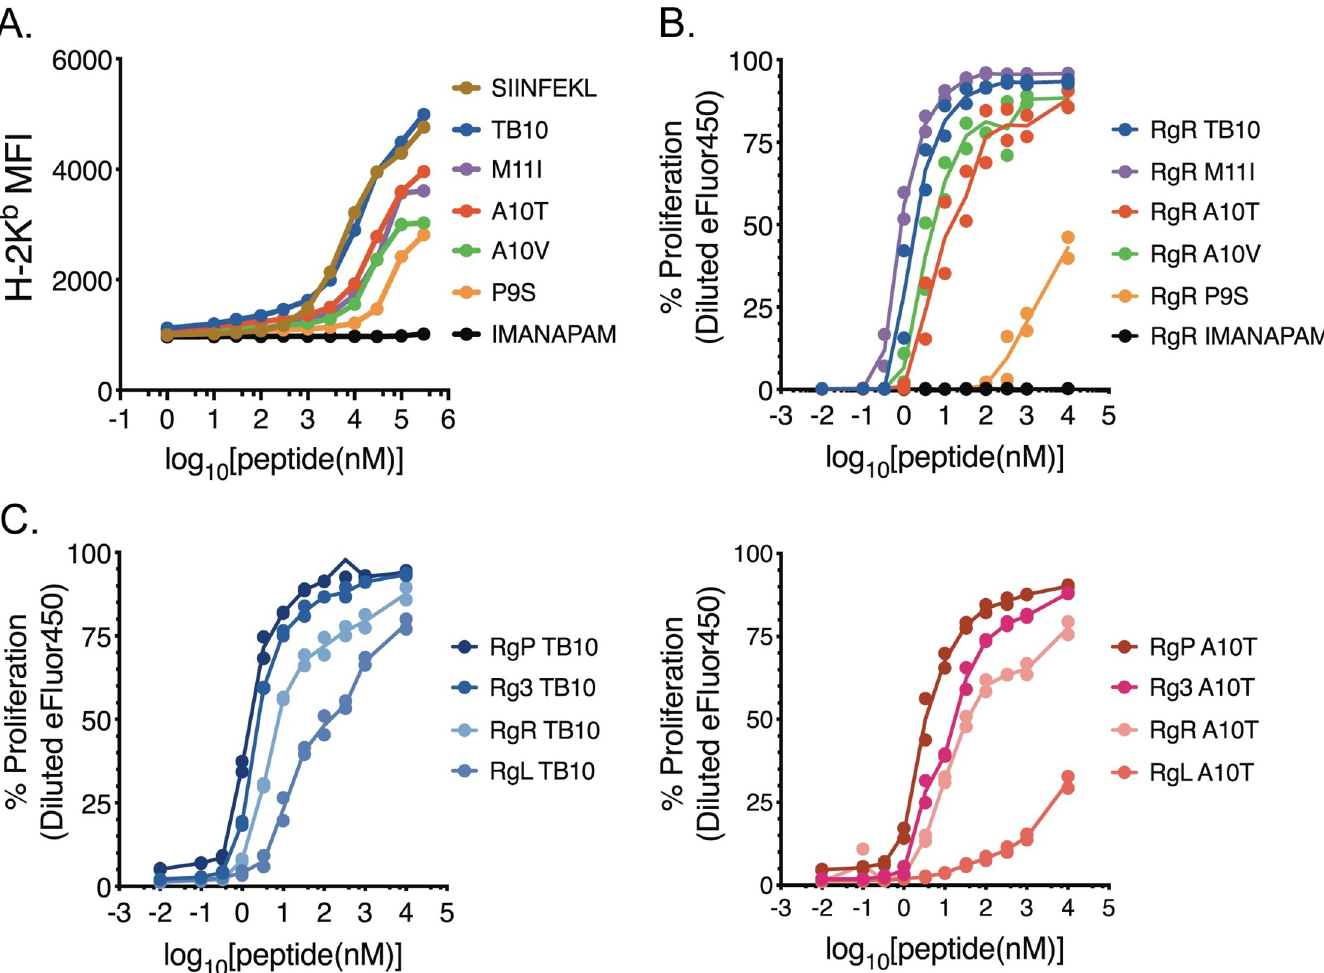
Fig 6. Naturally occurring variants of the TB10.4 4 peptides were titrated, added to RMA-S cells, and the relative H-2 K b surface expression (MFI) was determined by flow cytometry. The following peptides were used: SIINFEKL (positive control), IMANAPAM (negative control), “WT” TB10.4 4 proliferation of the